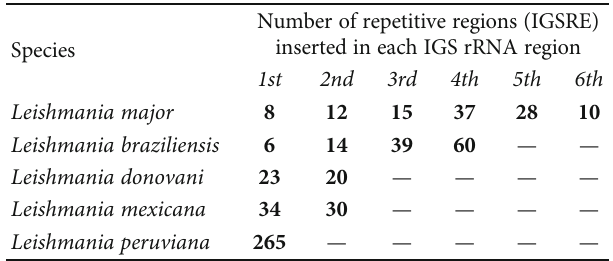
The number of repetitions of the IGS rRNA region inserted in Chromosome 27 is shown in italics. The quantity of repetitions of the IGSRE region for each IGS rRNA region, by Leishmania species, is shown in bold